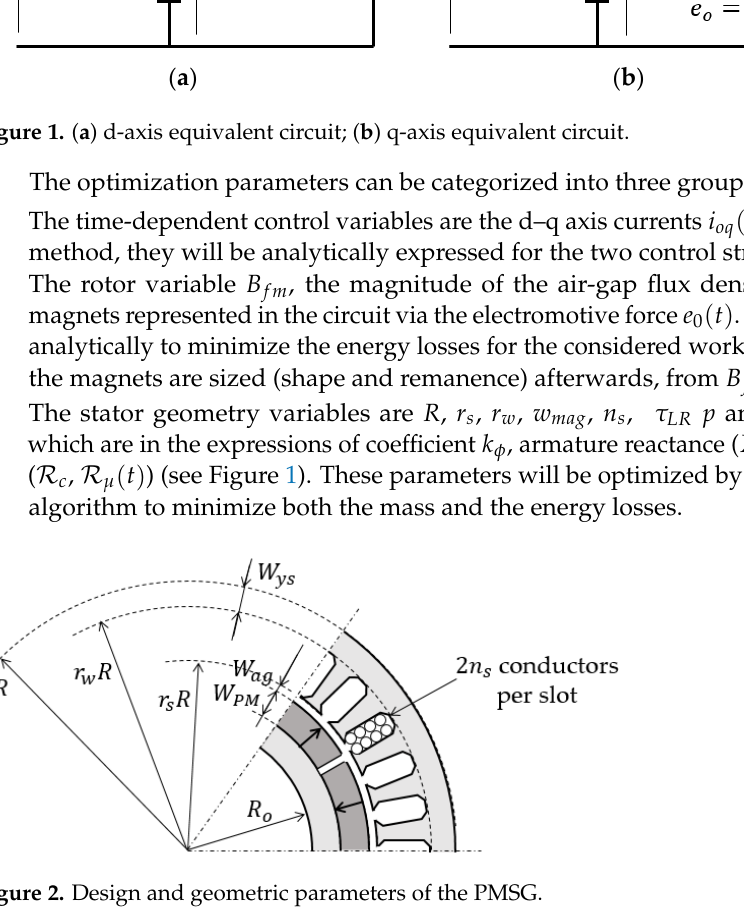
Figure 2. Design and geometric parameters of the PMSG.